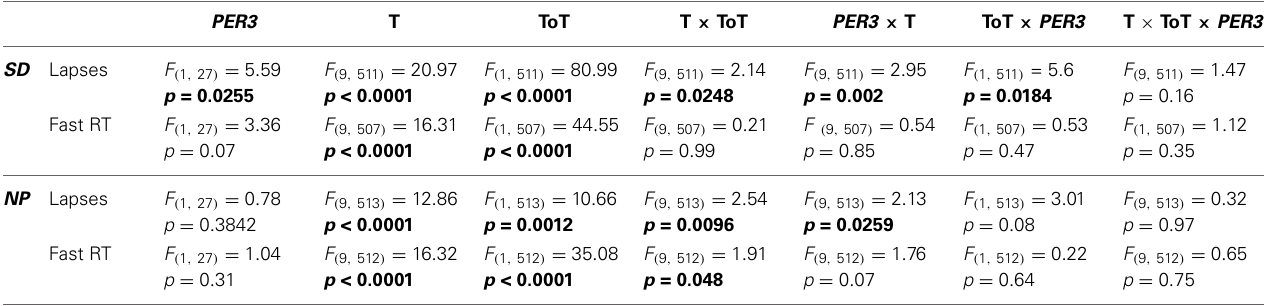
Table 2 | Results of mixed model ANOVA for time-on-task effects; F -values (df), and p-